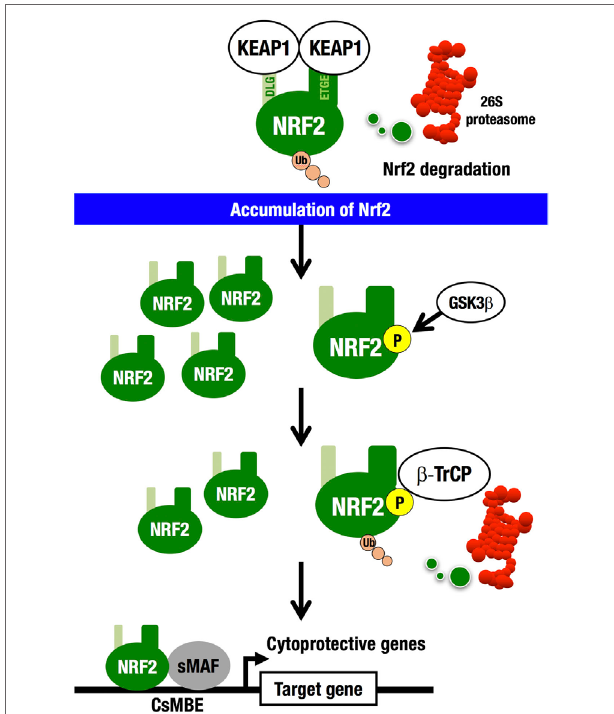
FigURe 2 | KeAP1–NRF2 system . KEAP1-CUL3 directly binds NRF2, which is then rapidly degraded by the 26S proteasome in the cytoplasm. NRF2 that escapes KEAP1 trapping is stabilized and accumulates in the nucleus. GSK3 phosphorylates the Neh6 domain of NRF2. Phosphorylated NRF2 binds β -TrCP-CUL1 and is then degraded by the 26S proteasome in the nucleus. NRF2 forms a heterodimer with sMAF and binds CNC-sMAF- binding elements (CsMBE), including the consensus ARE/EpRE sequence, TGACNNNGC. NRF2 upregulates cytoprotective genes encoding antioxidant enzymes and detoxifying